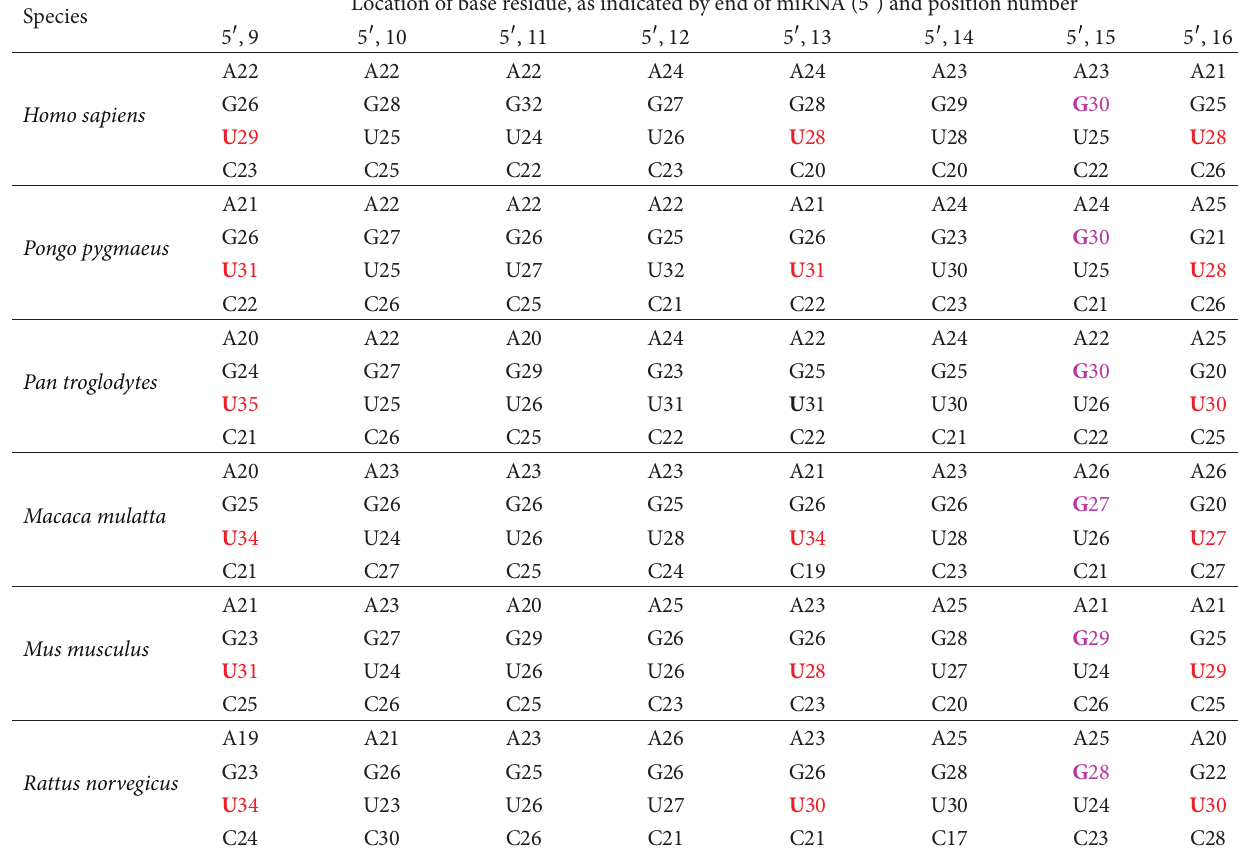
Table 3: Percentages (%) of A, G, U, and C in every mature miRNA of each species studied. This table contains base composition information for the ninth-through-sixteenth nucleotides from the 5 󸀠 end of the miRNAs. Bases shown in red are the most favored residues at positions 9, 13, and 16 of the 5 󸀠 end; bases in magenta are the most favored residues at position 15 of the 5 󸀠 end of the miRNAs examined. Location of base residue, as indicated by end of miRNA ( 5 ) and position Species